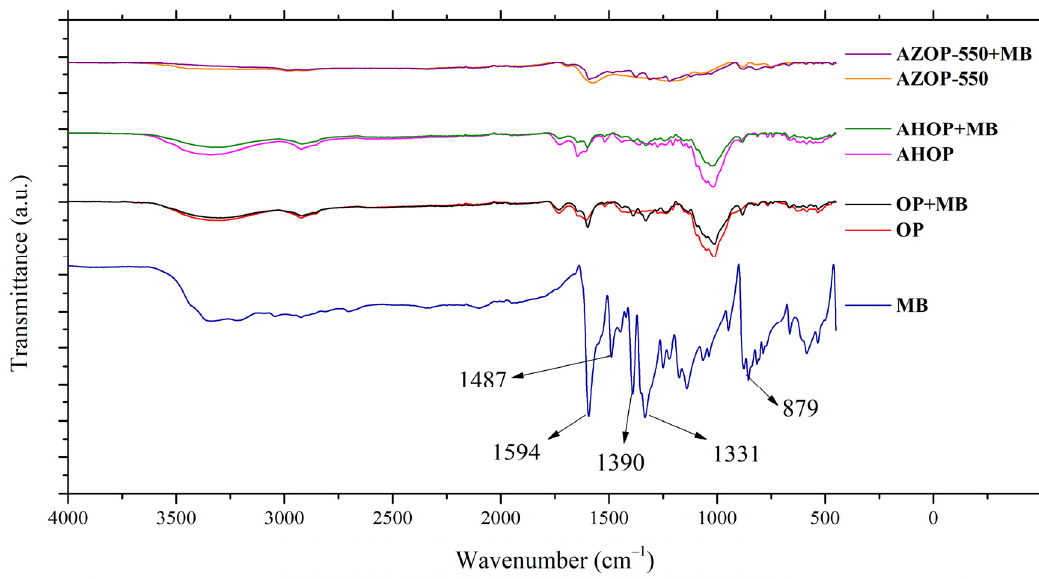
Figure 5. FTIR Spectra of the biochar materials under study before and after MB adsorption.